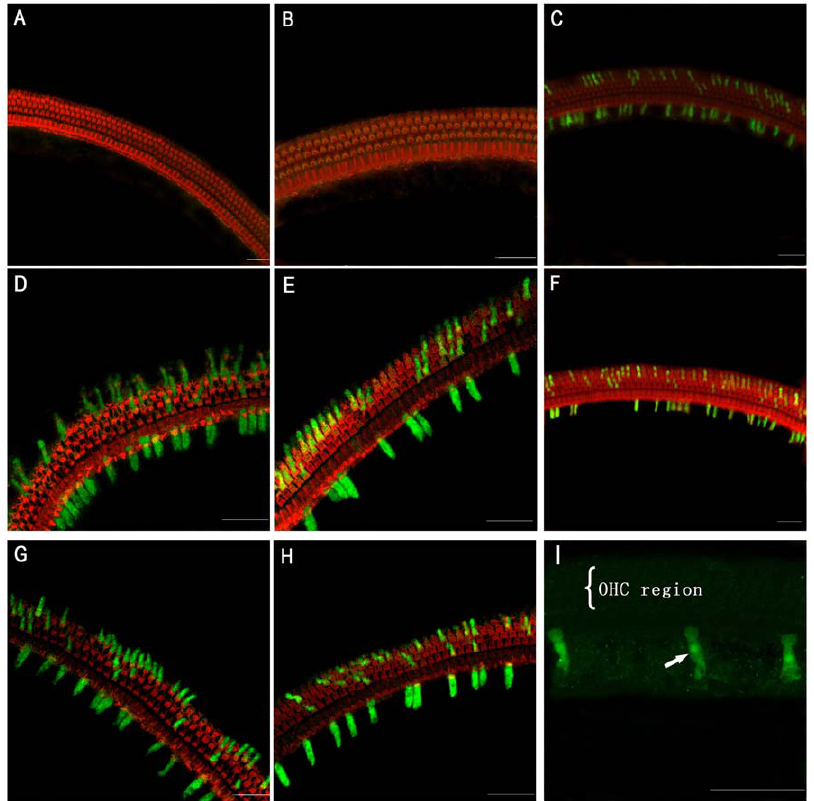
Figure 3. Mut-AAV-GFP transfection in the hair cells of neonatal mice 14 days postinoculation. A and B: Negative transfection in the hair cells of the collagenase 30 mg/mL group. C–E: Transfection in hair cells at different magnitudes in the collagenase 60 mg/mL subgroup, D: Apical turn, E: Basal turn. F–H: Transfection in hair cells viewed at different magnitudes in the RWM-puncture group. G: Apical turn, H: Basal turn. I: Sparse IHC transfection (arrow) seen in an ear contralateral to that receiving virus via RWM puncture. Scale bars=50 m m. RWM: round window membrane.